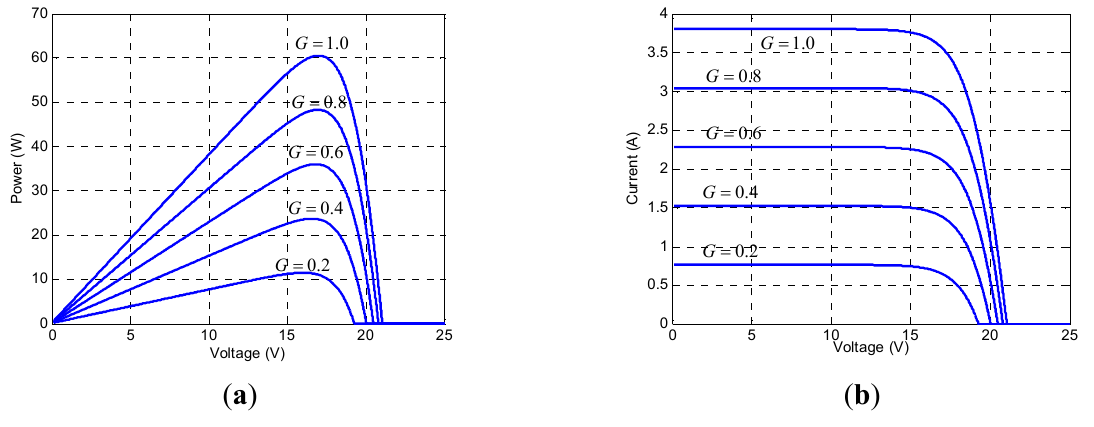
Figure 1. PV panel characteristics. ( a ) Power versus voltage; ( b ) Current versus